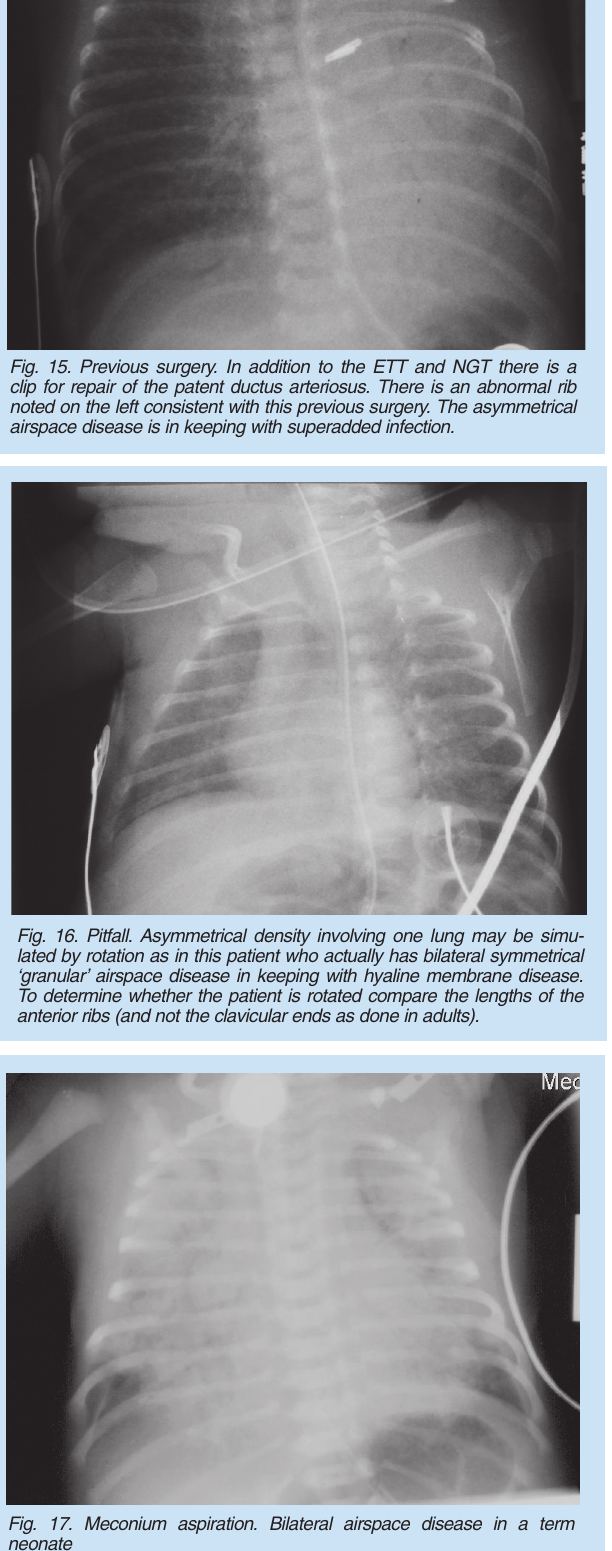
Fig. 17. Meconium aspiration. Bilateral airspace disease in a term neonate